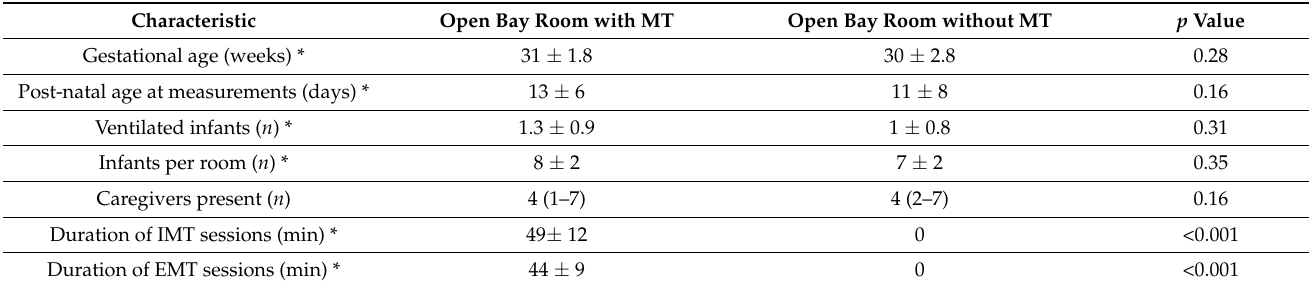
Table 1. Patient